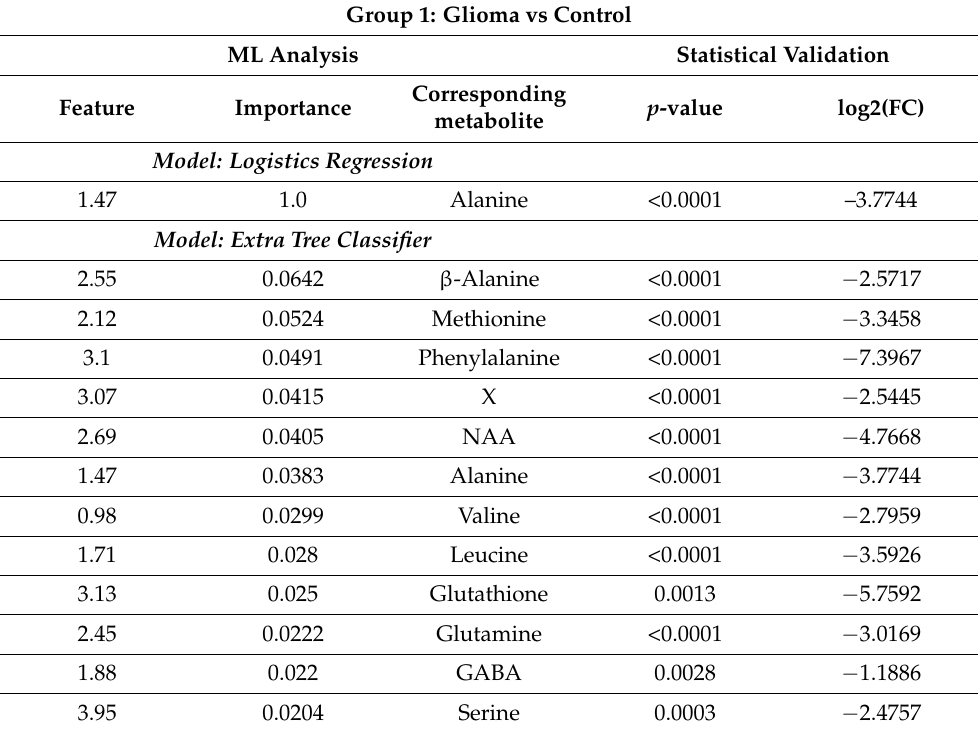
Table 3. Top 30 spectral regions and their contributing metabolites identified by both sets of ML analysis given in descending order of importance along with their statistical